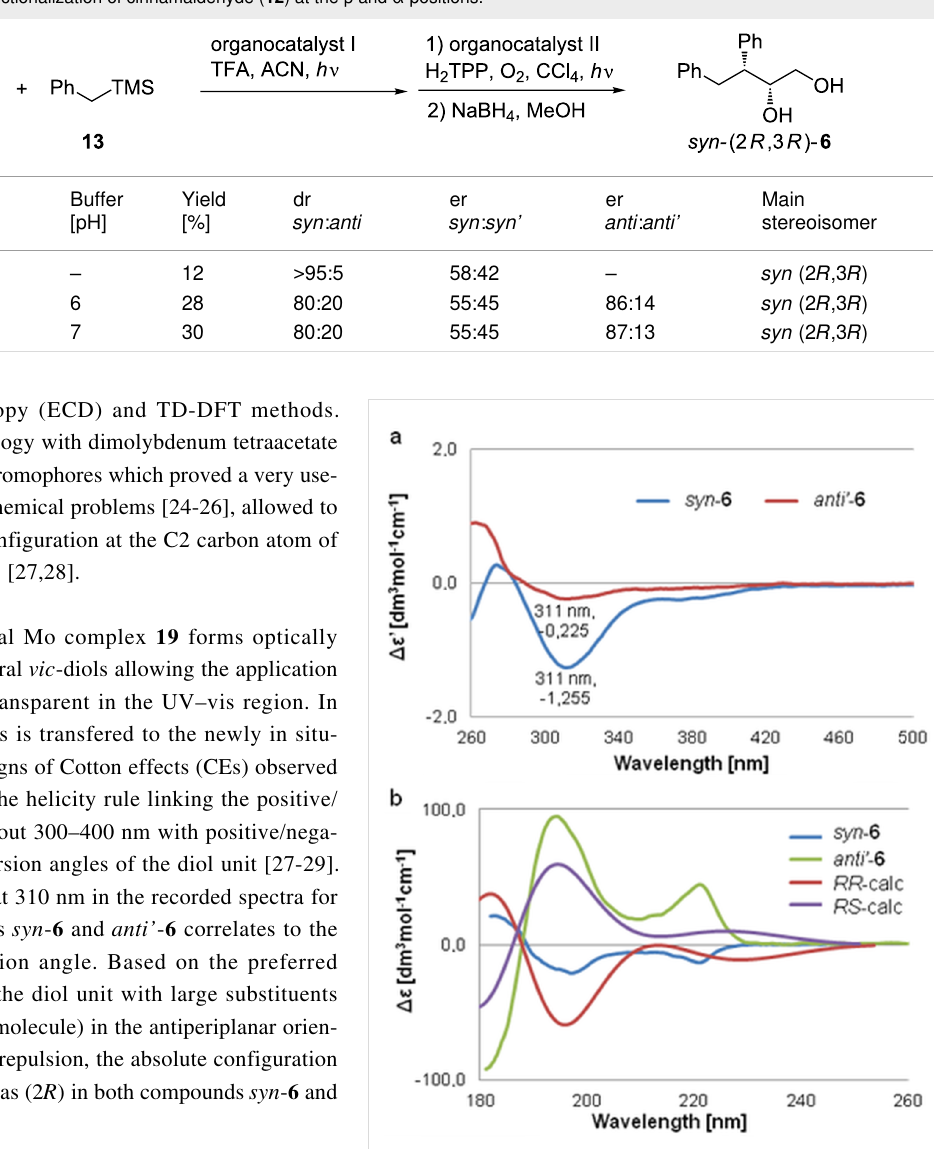
Table 2: Photochemical difunctionalization of cinnamaldehyde ( 12 ) at the β and α -positions.